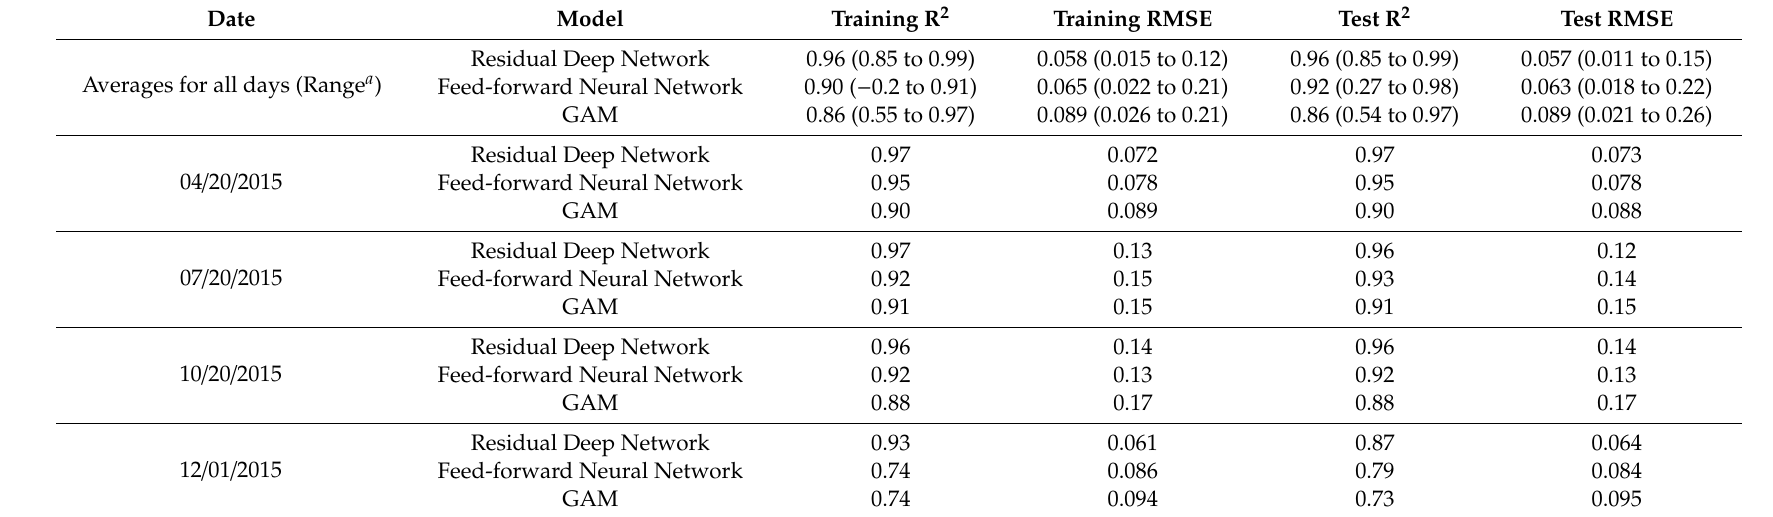
Table 1. Comparison of GAM, feed-forward neural network and residual deep network for daily-level MAIAC AOD imputation. Date Averages for all days (Range a